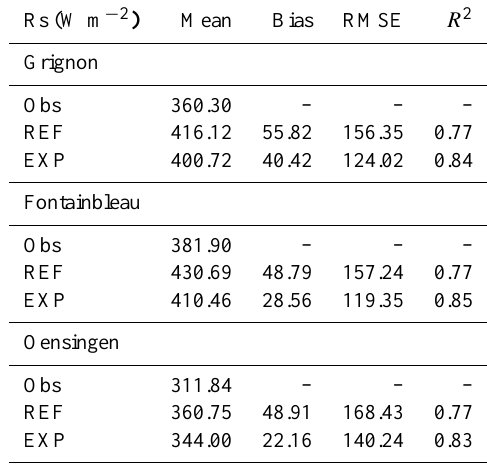
Table 2. Statistics of the incoming shortwave radiation for the entire month of June 2006.